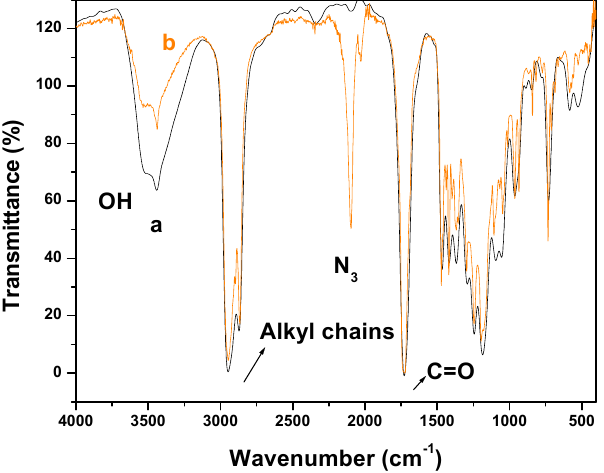
Figure 3. FTIR spectra of PCL ( a ) and azido-polycaprolactone (PCL-N3) ( b ).